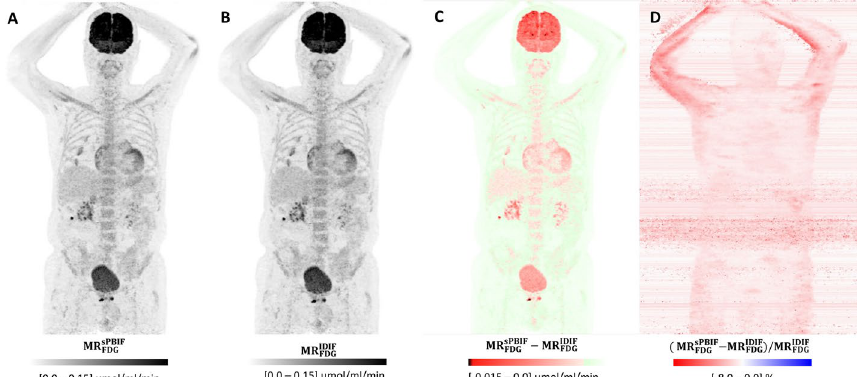
Fig. 5 Effect of PBIF illustrated using MIP images of Patlak MR FDG calculated using 4 5-min WB passes × (50–70 min). A MR FDG based on a 20-min D-WB scan (50–70 min) and sPBIF; B MR FDG based on a full 70-min IDIF; C Absolute difference image; and D Relative difference image. The two MR FDG images ( A ) and ( B ) are visually identical. However, the absolute difference image ( C ) shows that the PBIF-based MR FDG image has systematically lower values than the IDIF-based MR FDG image. The relative difference image ( D ) shows almost no anatomical structures, which indicates a constant relative bias. For this patient, the use of sPBIF lead to 4% higher AUC, and consequently to 4% lower MR FDG values. The few structures, e.g. arms, seen on ( D ) are areas with very low MR FDG values. The input function for this patient can be found in Additional file 1: Fig.